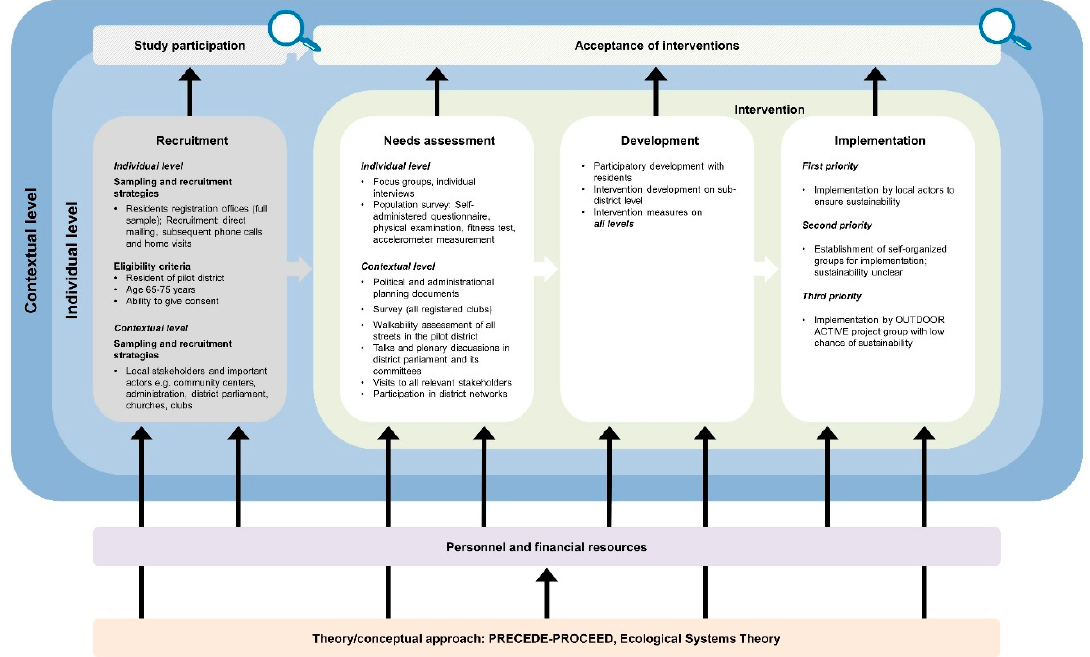
Figure 4. Specific equity-focused logic model for the multilevel participatory community-based outdoor physical activity program for older adults implemented in OUTDOOR ACTIVE. In funding phase one, OUTDOOR ACTIVE was designed as a pilot study and did not contain an outcome evaluation. In funding phase two, the efficacy of the developed intervention approach will be evaluated in a cluster-randomized trial [44].